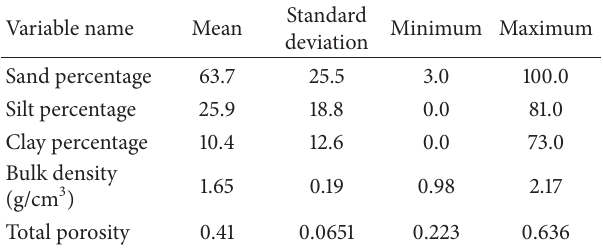
Table 1: Basic statistics of the soil dataset.